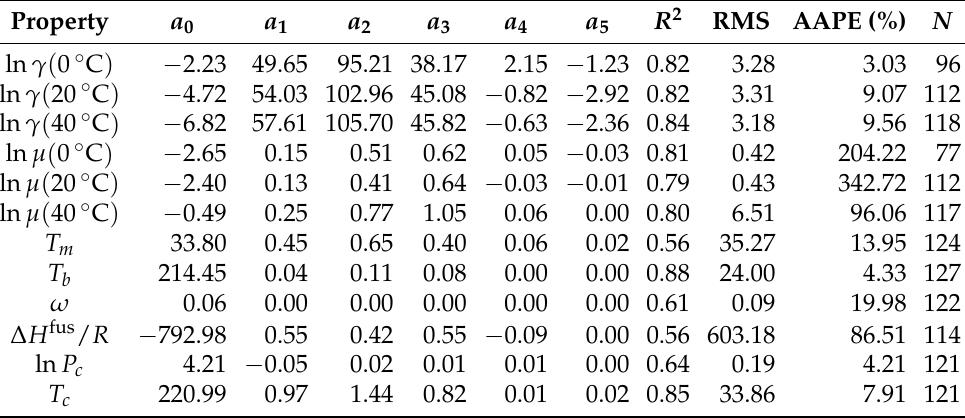
Table 6. Summary of the regressed model parameters using Equations (22)–(29) along with the Pearson correlation coefficient ( R 2 ), the root-mean-squared error (RMS), and the average absolute percent error (AAPE) to assess the goodness of fit, where N corresponds to the number of organic compounds included in the fit. In the correlations, γ is in units of dyn/cm, µ is in cP, T m , T b , and T c are all in K, ω is dimensionless, ∆ H fus / R is in units of K, and P c is in units of bar. When applicable, the temperature indicates the temperature at which the regression was